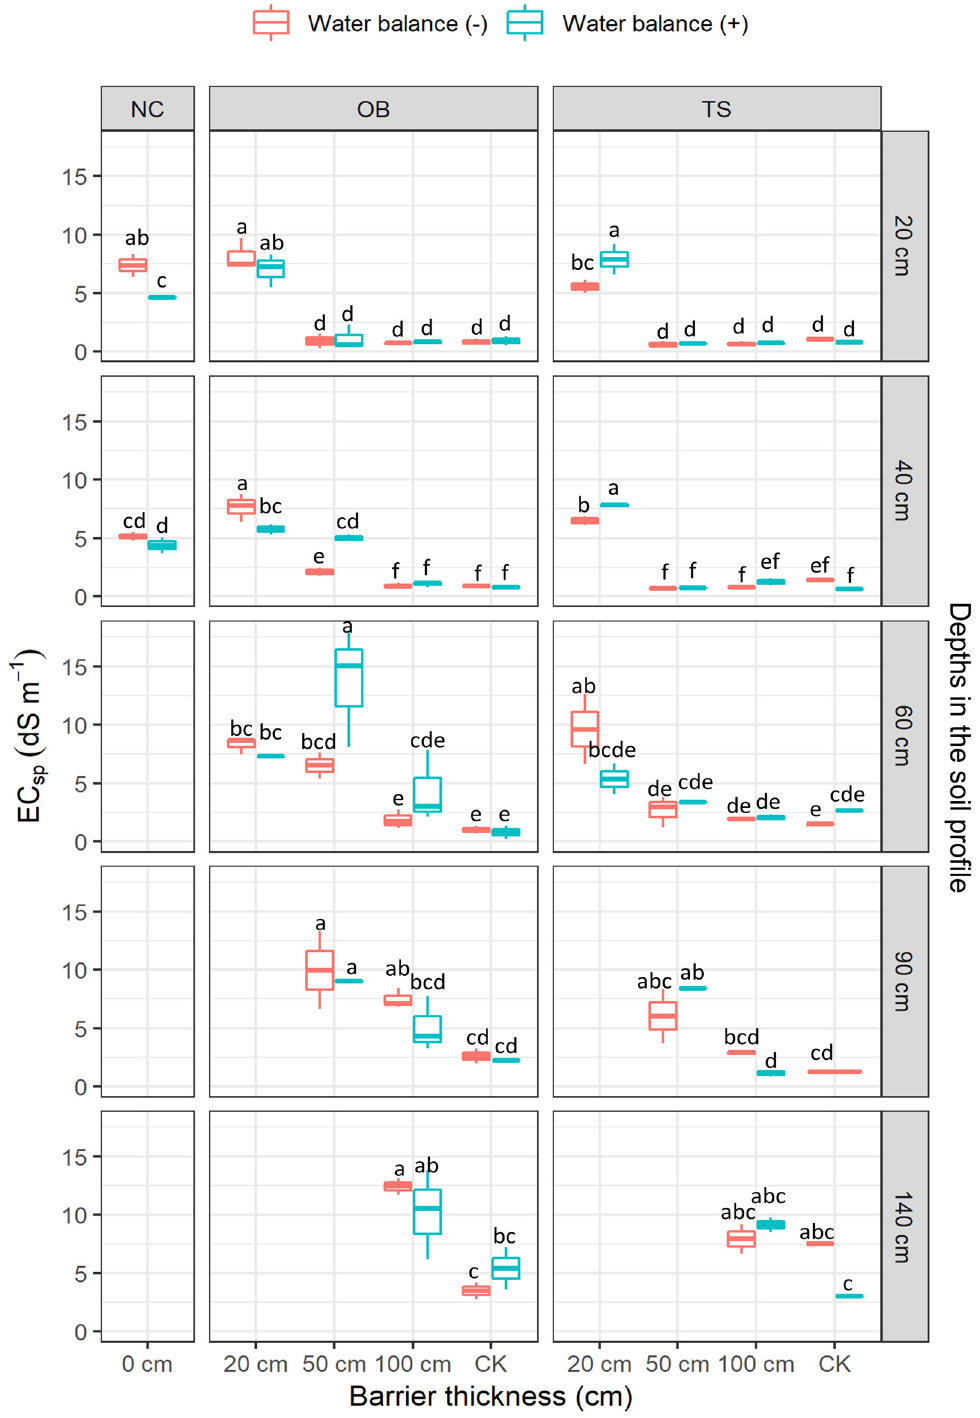
Figure 6. Salinization in cover soils after 3 growing seasons. Different letters in a row indicate significant differences ( p < 0.05, ANOVA) among treatments at the same depth, which were derived by comparing all the values across the NC, OB and TS trials.